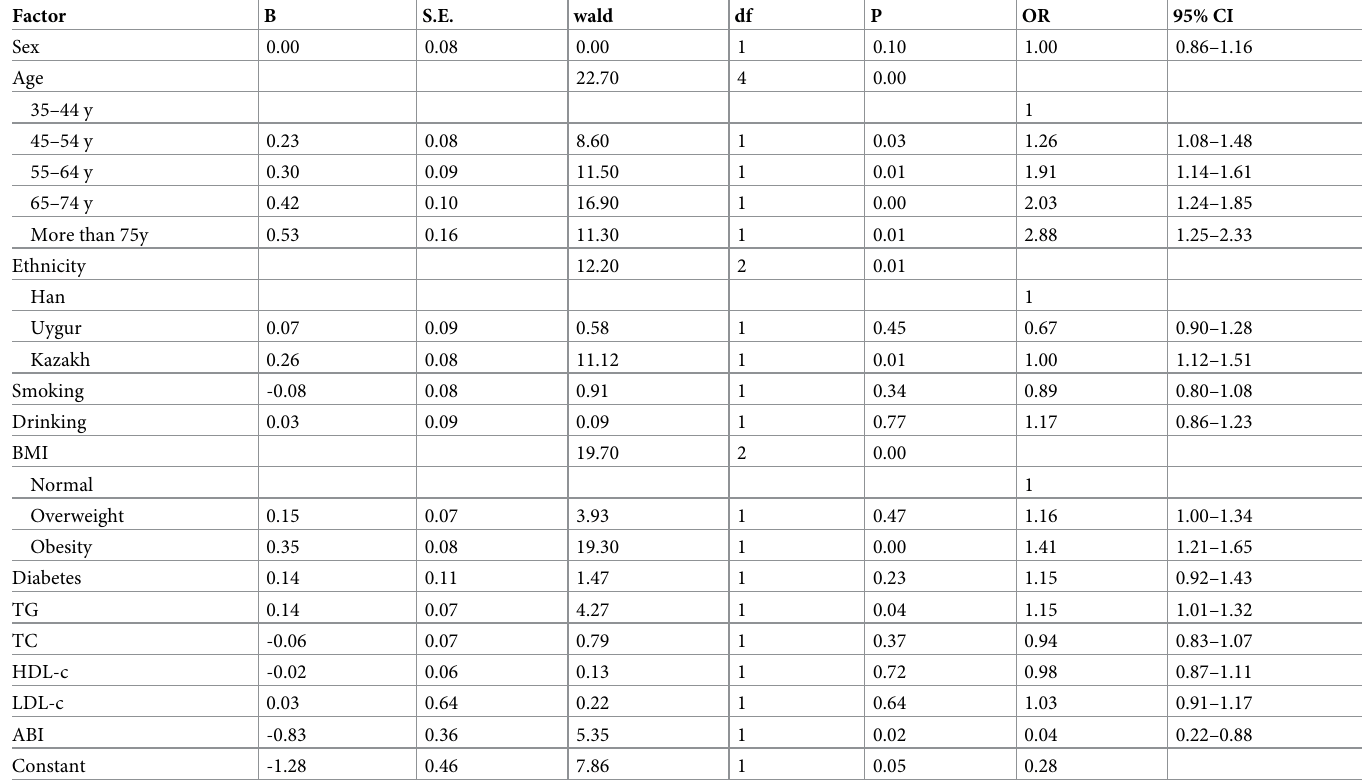
Table 5. Multivariate unconditional logistic regression analysis of risk factors for abnormal IAD in the general